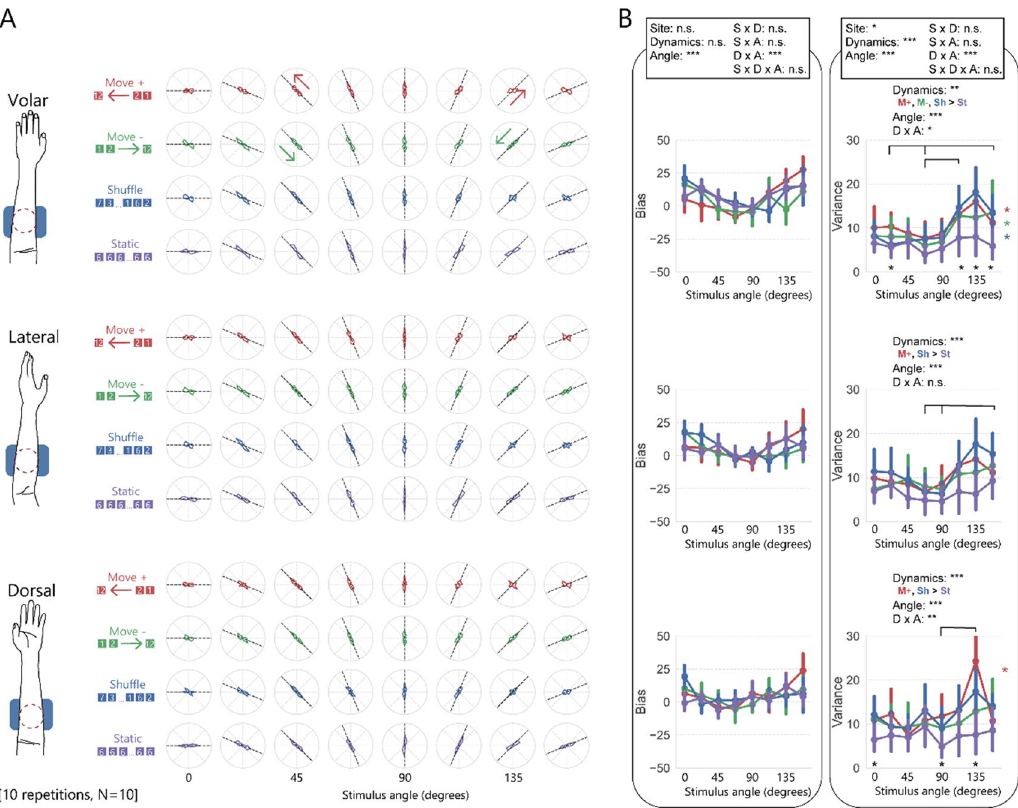
Figure 5. Results of Experiment 4. (A) The average rate of the stimulus orientation reported by the participants under volar, lateral, and dorsal conditions. (B) Biases and variances of the reported orientations. The error bars represent 95% CIs. Notes in the box above panels represent the results of the main analysis for all stimulus sites, while notes above each panel represent the results of the post-hoc analysis for only one of the stimulus sites. A partial analysis for each site was not conducted for the bias